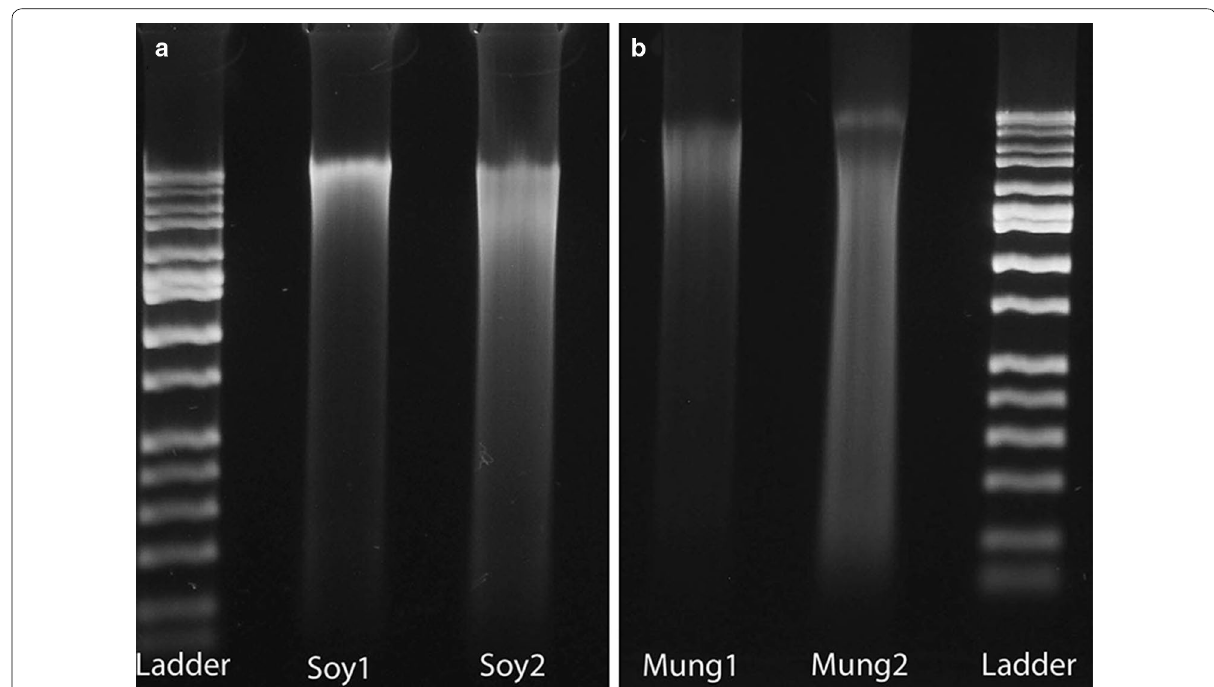
Fig. 1 Electrophoretic separations of total DNA isolated from two separate root nodules from Glycine max cv. Tara ( a ) and Vigna radiata cv. Crystal ( b ) compared to DNA size standard ladders that range from 50 to 10 kb. The concentration and degree of DNA fragmentation varied among